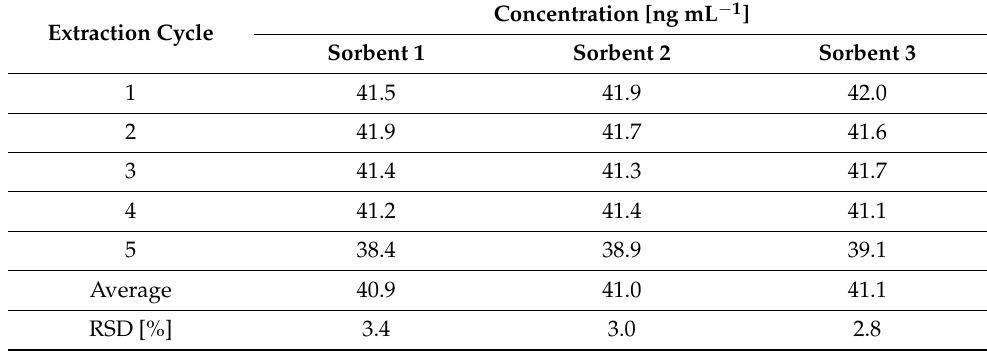
Table 4. Reusability of DES sorbents.